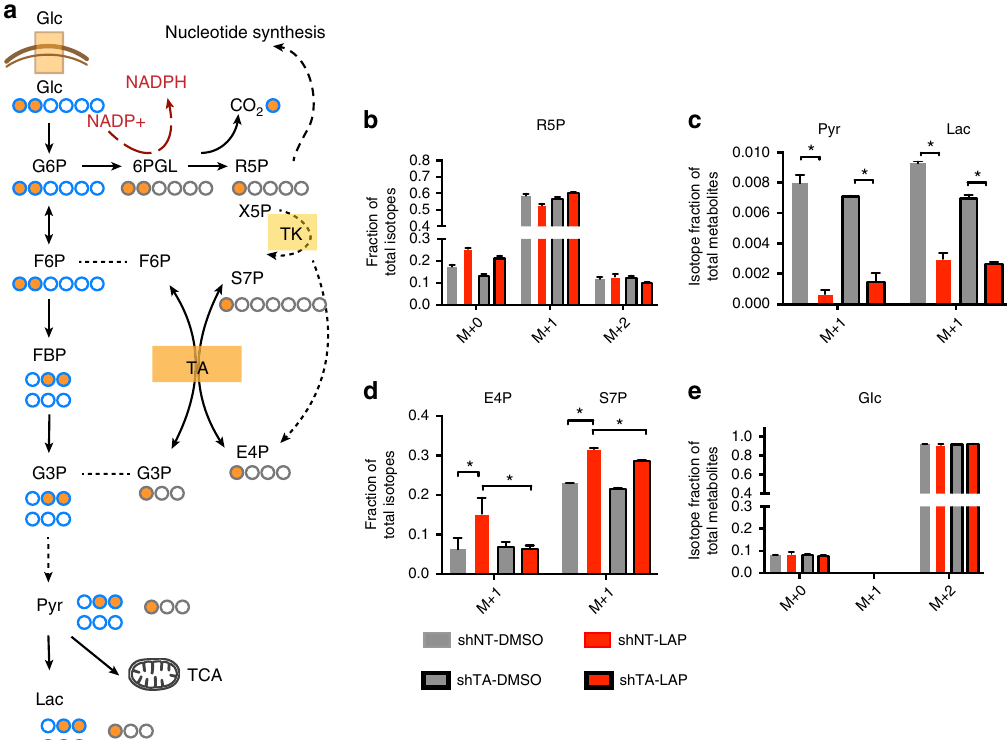
Fig. 4 The TA-mediated non-oxidative PPP replenishes the oxidative PPP. a Schematic depicting the fate of labeled 13 C (orange- fi lled) from 1,2- 13 C 2 -labeled glucose in glycolytic 51 and PPP (gray) intermediates. Abbreviations: Glc, glucose; G6P, glucose-6-phosphate; 6PGLU, 6-phosphogluconate; R5P, ribulose- 5-phosphate; F6P, fructose-6-phosphate; FBP, fructose-1,2-biphosphate; G3P, glyceraldhyde-3-phosphate; S7P, sedoheptulose-7-phosphate; E4P, erythrose-4-phosphate; Pyr, pyruvate; Lac, lactate. b – e Normalized peak areas and distributions of isotopomers of the indicated metabolites. MDA-MB-361 cells were treated with 4 μ M lapatinib or DMSO for 24 h, at which point 1,2- 13 C 2 -glucose supplemented media with DMSO or lapatinib were added and cells were treated for another 24 h before sample collection. * P < 0.01 by student t -test, error bars denote the SD ( n =